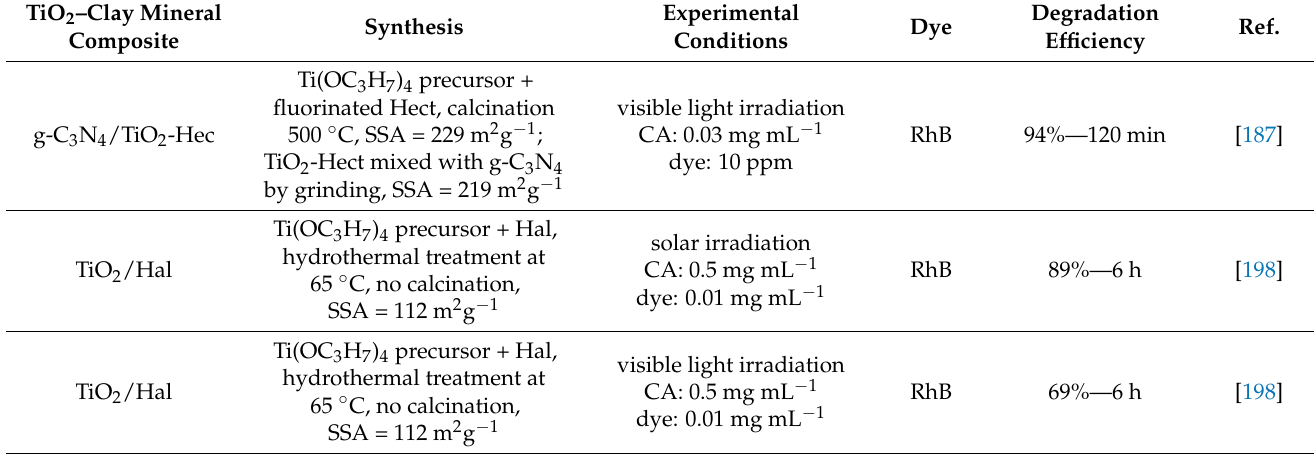
Table 5. Main synthesis and photocatalysis data for examples of TiO 2 composites with clay minerals other than mont- morillonite, which were used as photocatalysts for the degradation of dyes (AO7—Acid Orange 7, Acid Red G—ARG, CR—Congo Red, GV—Gentian Violet, MB—Methylene Blue, MG—Methyl Green, MO—Methyl Orange, MOII—Methyl Orange II, OG—Orange G, BPB—bromophenol blue, RhB—Rhodamine B, RhG—Rhodamine G, SRB—sulforhodamine